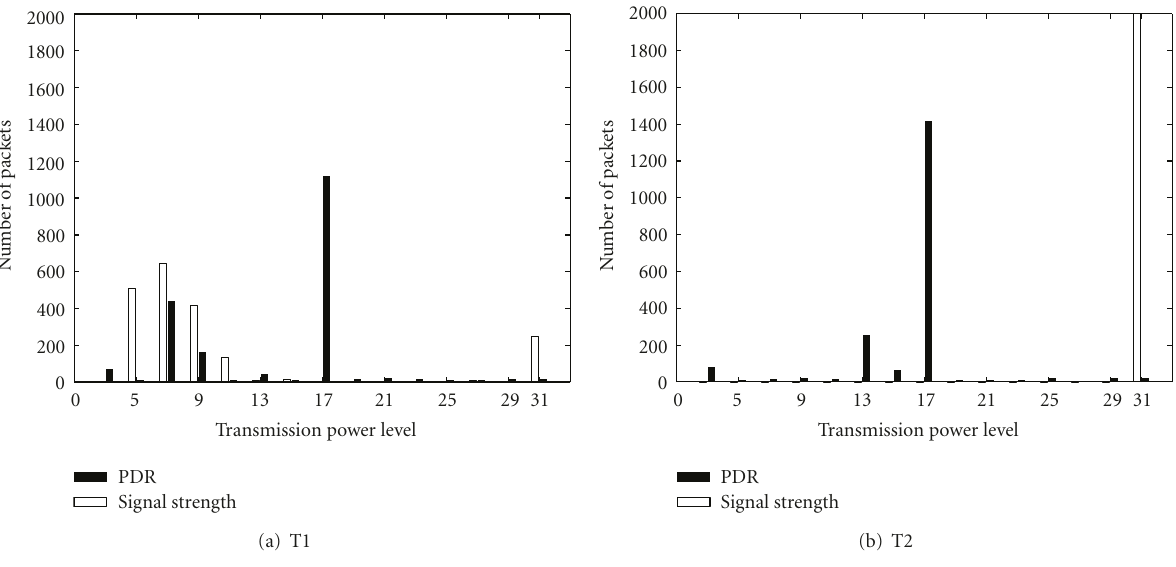
Figure 15: The transmission power levels distribution for the proposed and signal strength-based algorithms in the two